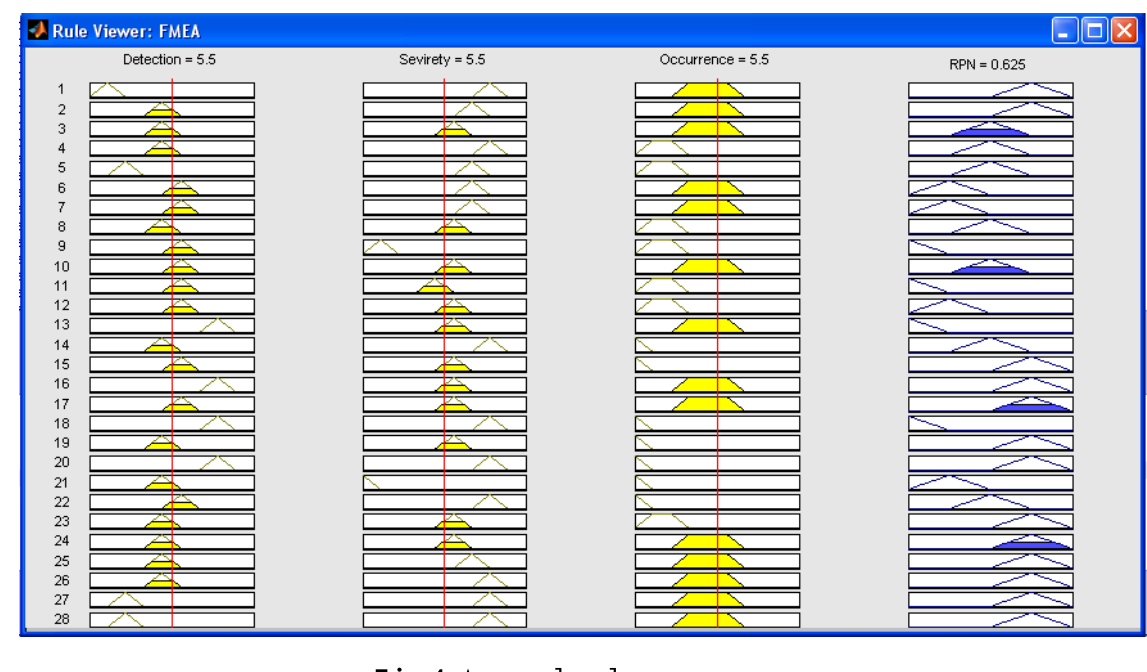
Fig. 4. A sample rule